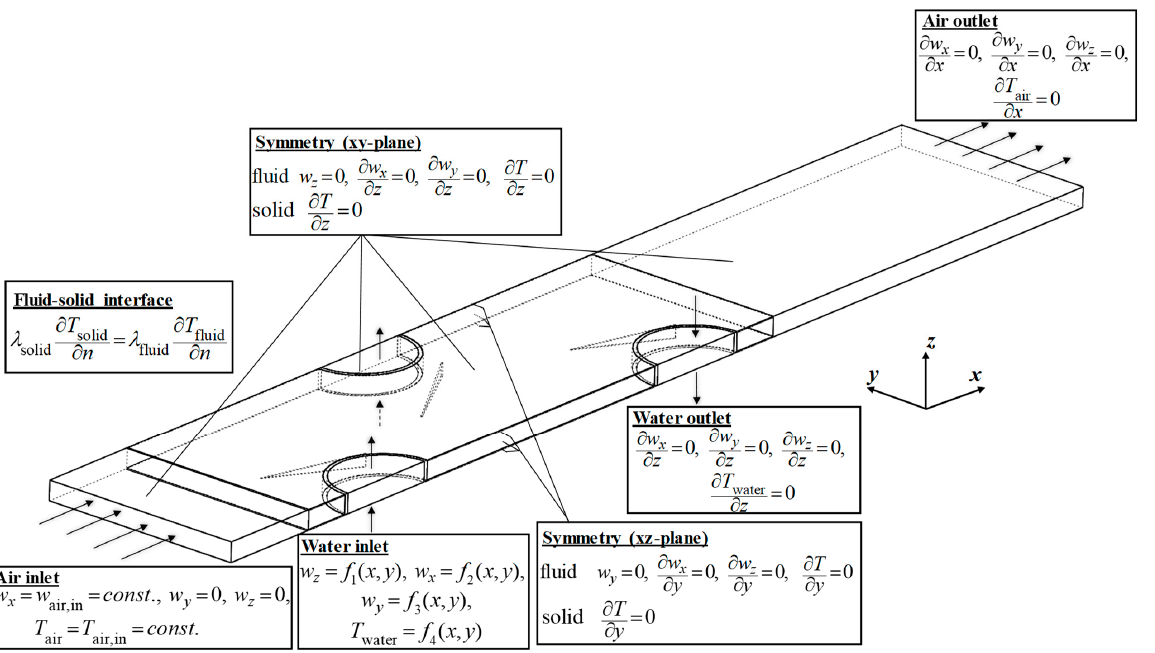
Figure 5. Schematic view of the boundary conditions for FTHEX with delta-winglet type vortex generators.